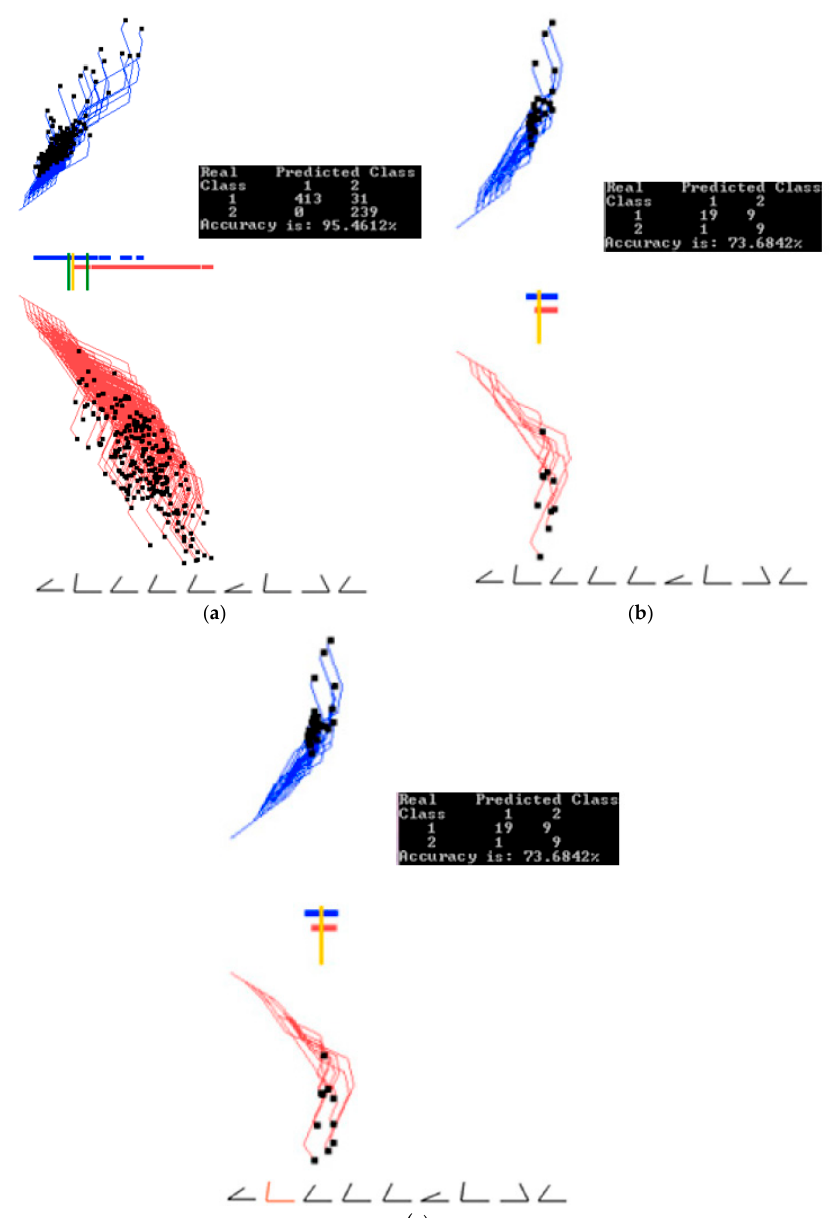
Figure 9. Wisconsin breast cancer data interactively projecting a selected subset. ( a ) Two thresholds are set from Figure 8c for selecting overlapping cases. ( b ) Overlapping cases from the interval between two thresholds from (a). ( c ) Overlapping cases from the interval between two thresholds, with the 2nd dimension with low contribution removed without decreasing accuracy.